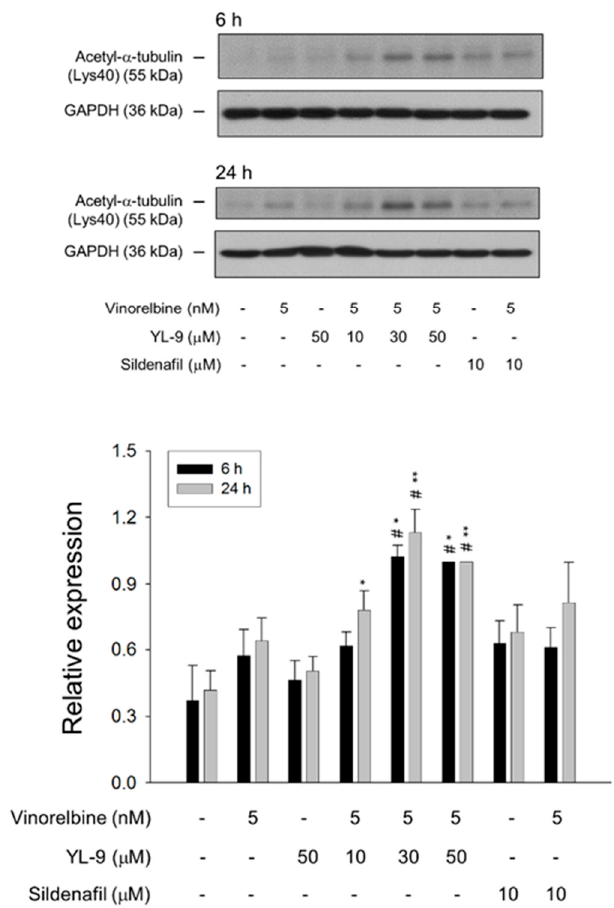
Figure 7. E ff ect of YL-9 on vinorelbine-induced acetylation of α -tubulin. NCI-H460 cells were incubated with the indicated agents for 6 or 24 h. After the treatment, the cells were harvested for the detection of protein expression using Western blotting analysis. The expression was quantified using Bio-Rad Image Lab TM Software. The expression is relative to the group of 5 nM vinorelbine / 50 µ M YL-9. Data are expressed as mean ± SEM of three independent experiments. * p < 0.05 and ** p < 0.01 compared with the control. # p < 0.05 compared with vinorelbine alone.